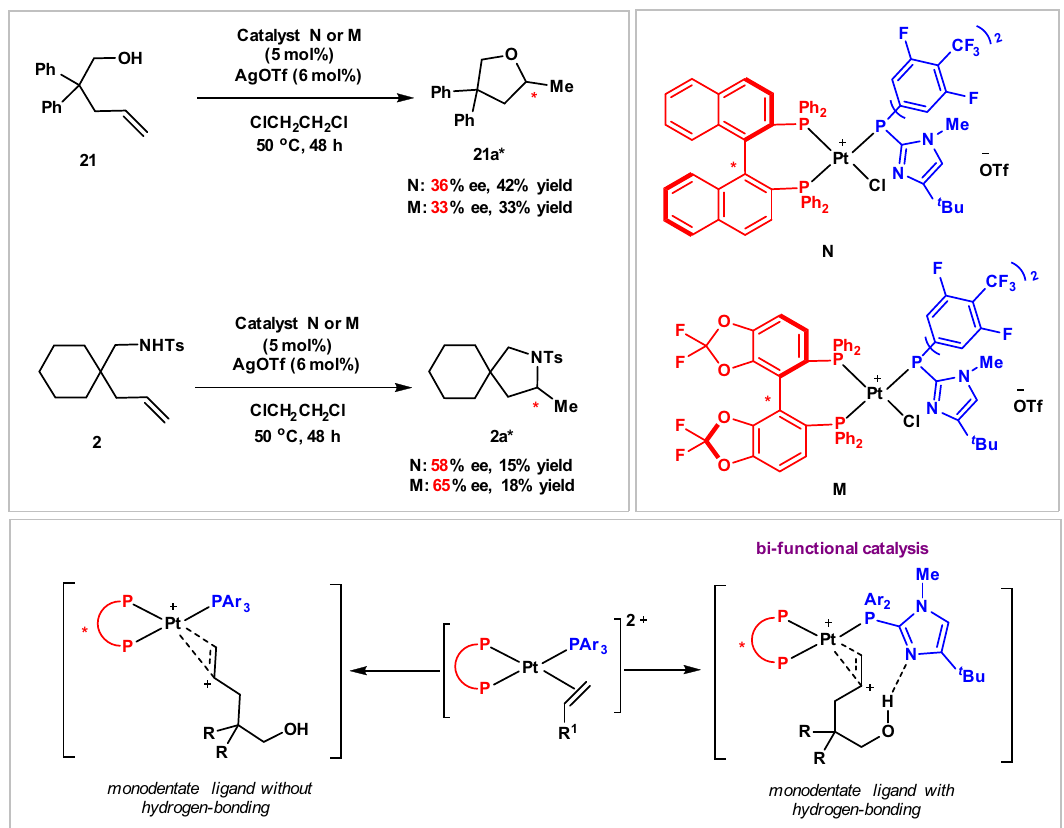
Fig. 7 Development of bi-functional catalysis for catalytic asymmetric hydroalkoxylation and hydroamination. a Pt-catalyzed asymmetric intermolecular hydroalkoxylation and hydroamination of unactivated alkenes. b Catalysts N and M . c Bi-functional catalysis for asymmetric hydroalkoxylation and hydroamiantion.